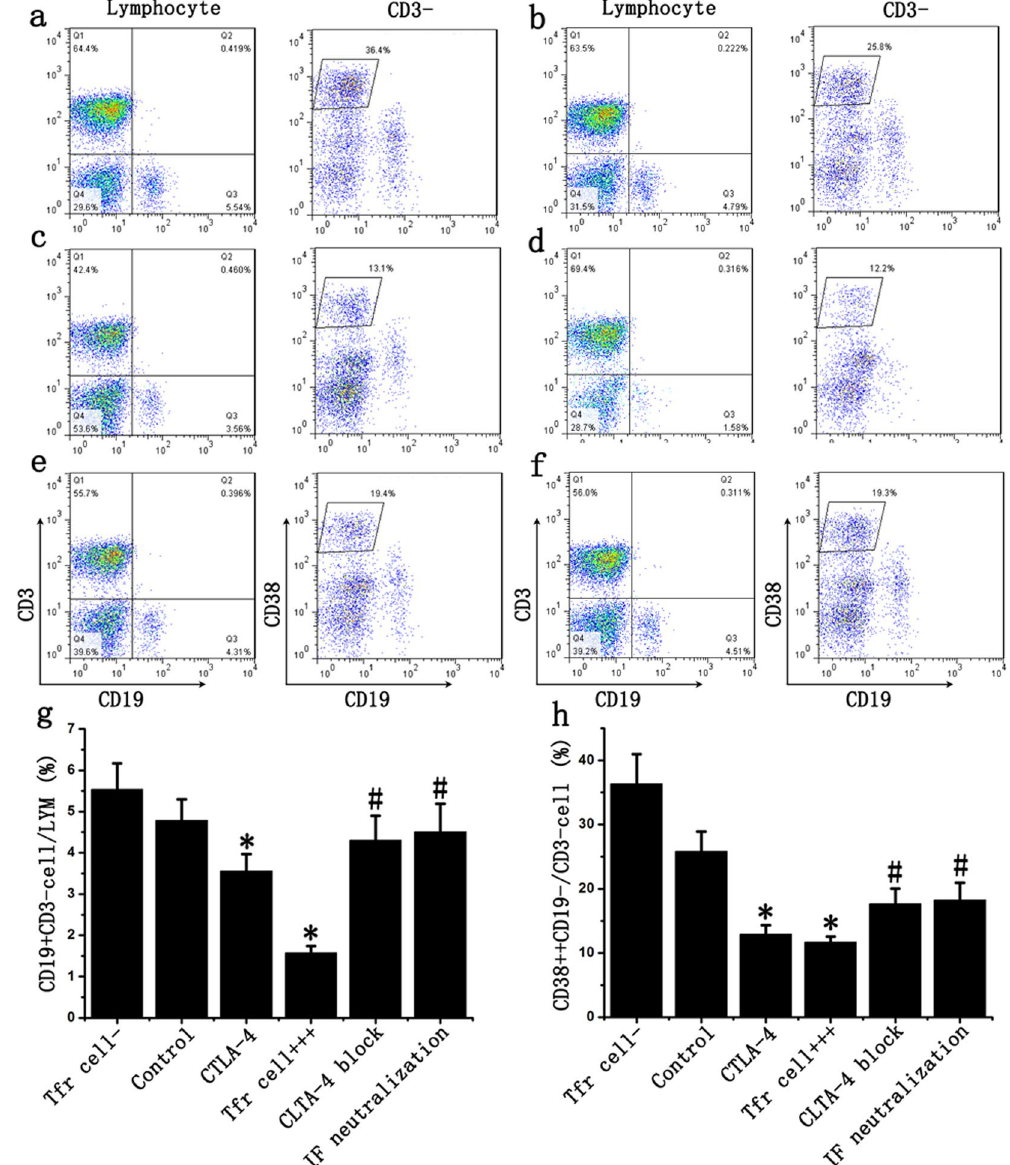
Figure 4. Tfr cells inhibited B cell to differentiate into plasma cells in renal transplantation. Tfr cells were sorted from AMR patients and divided into many groups: Tfr cells deleted group (Tfr cell − , a ), Tfr cells normal ratio group (Control, b ), CTLA-4 group ( c ) and Tfr cells ratio increase group (Tfr cell +++ d ). In Tfr cell +++ group, CTLA-4 antibody was used to block CTLA-4 of Tfr cells (CTLA-4 block ( e ); IL-10 and TGF- β antibody was used to neutralize the inhibitory factors from Tfr cells (IF neutralization, f ). ( g ) The ratio of B cells in Tfr cells +++ and CTLA-4 group decreased compared with control group, while CTLA-4 blocking, IL-10 and TGF- β neutralization could partially suppressed this decrease of B cells. ( h ) Tfr cells and CTLA-4 inhibit B cell differentiation into plasma cells and CTLA-4 blocking, IL-10 and TGF- β neutralization could partially lessen the inhibitory effect of Tfr cells. Student’s t test: * p < 0.05 (n = 6) versus Control; # p < 0.05 (n = 6) versus Tfr cells +++ . Values are mean ±